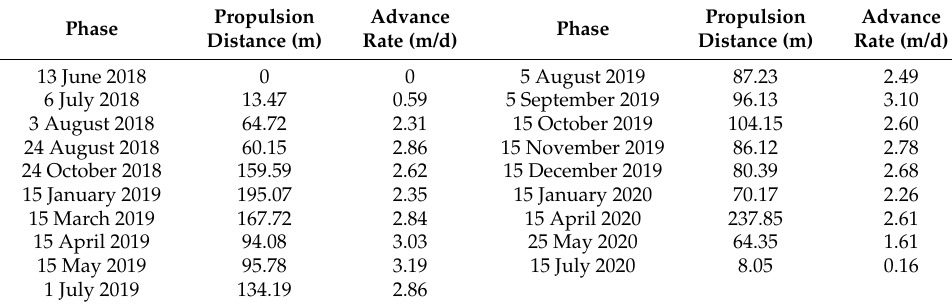
Table 5. The propulsion status in different